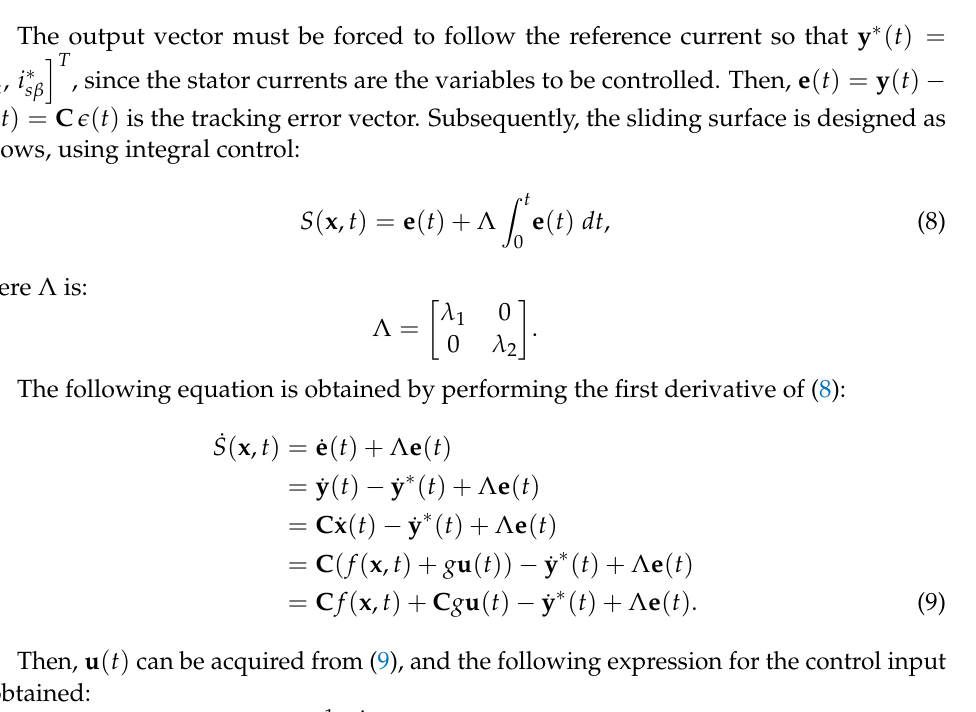
Figure 3. Proposed control method based on the